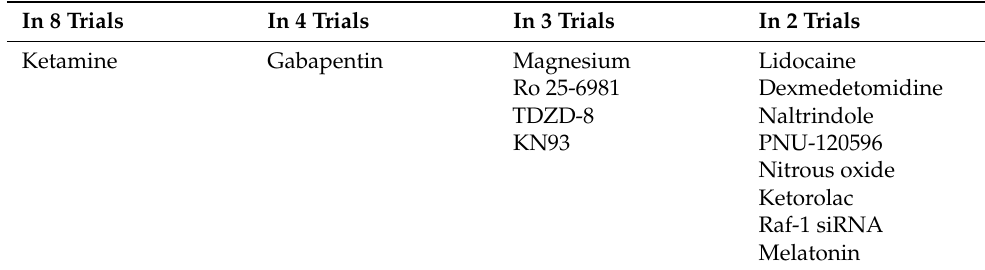
Table 5. Interventions investigated overall in more than one trial. More than one trial was devoted to studying 14 of 82 interventions. Ketamine was the most-studied intervention.